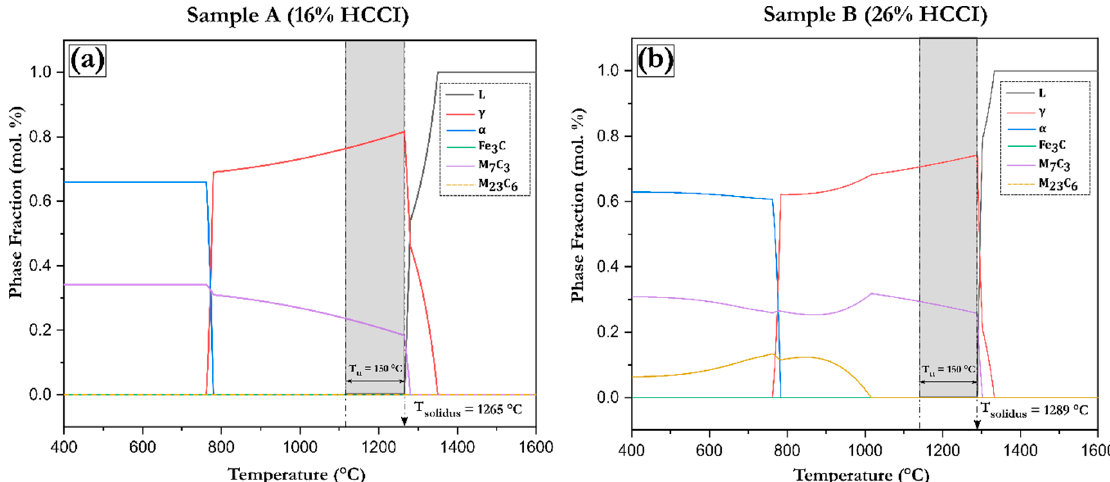
Figure 6. Equilibrium phase fractions for ( a ) Sample A (16% HCCI) and ( b ) Sample B (26% HCCI) as predicted by MatCalc. The solidus temperature, T solidus for both alloys including the range of undercooling considered, T u = 150 °C is indicated in the schematic.